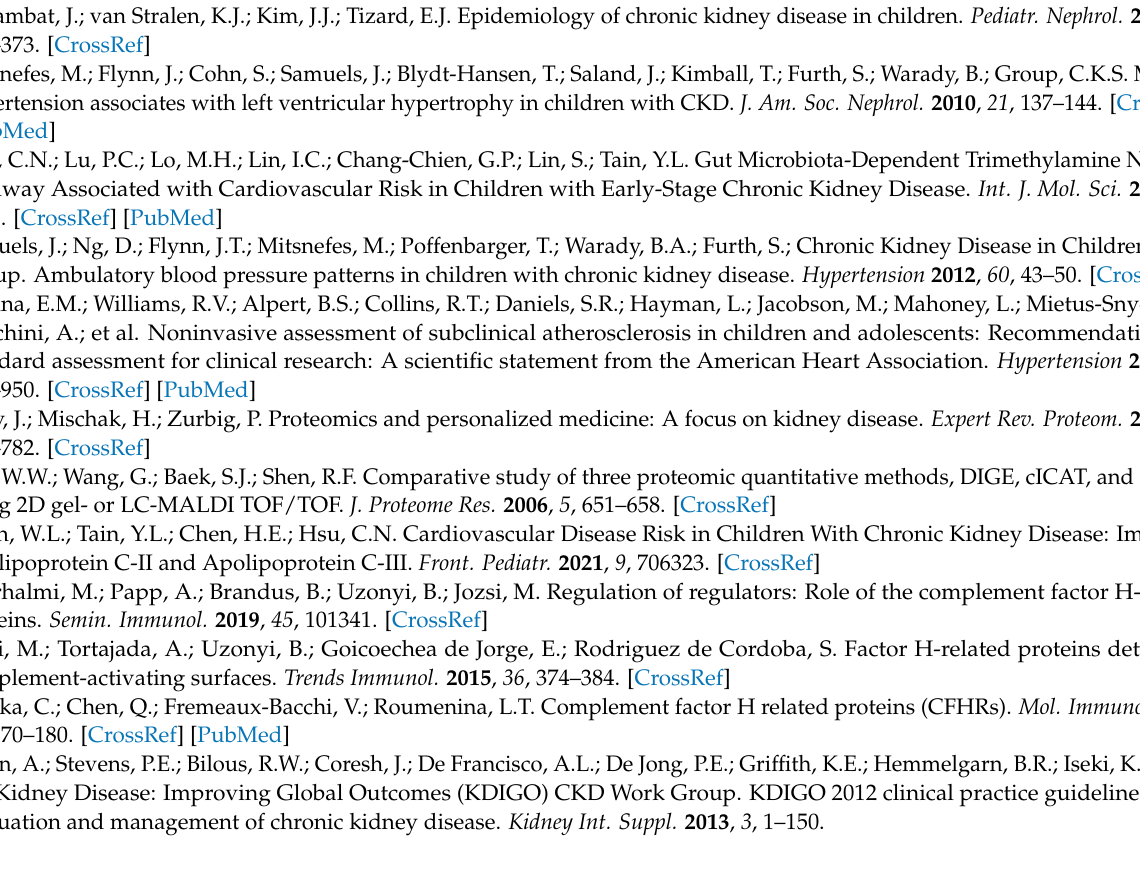
Table S3: Plasma level of CFH, CFHR2, CFHR3 vs. ABPM profile in the CAKUT group.; Table S4: Plasma level of CFH, CFHR2, CFHR3 vs. ABPM profile in the non-CAKUT